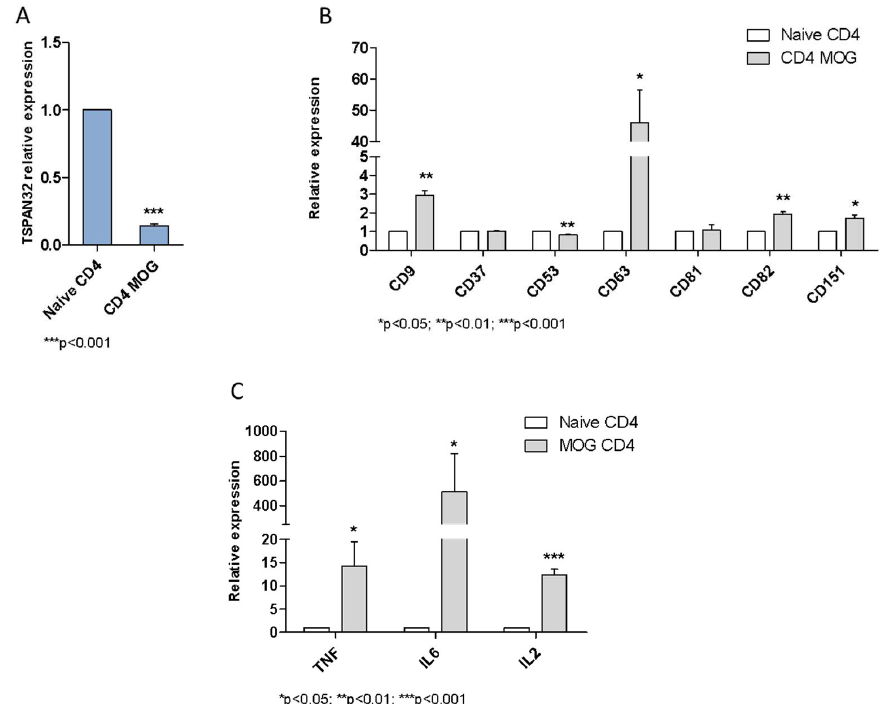
Figure 5. Modulation of TSPAN32 in experimental allergic encephalomyelitis (EAE). ( A ) Expression of TSPAN32 was evaluated using real-time PCR in CD4 + T cells isolated from the brains and spinal cords of mice with EAE. Control cells are represented by CD4 + T cells isolated from the spleens of sham mice ( n = 3 replicates, each of 3 pooled animals). ( B ) Expression of CD9, CD37, CD53, CD63, CD81, CD82 and CD151 was evaluated using real-time PCR in CD4 + T cells isolated from the brains and spinal cords of mice with EAE. Control cells are represented by CD4 + T cells isolated from the spleens of sham mice ( n = 3 replicates, each of 3 pooled animals). ( C ) Expression of TNF-alpha, IL-6 and IL-2 was evaluated by real-time PCR in CD4 + T cells isolated from the brains and spinal cords of mice with EAE. Control cells are represented by CD4 + T cells isolated from the spleens of sham mice ( n = 3 replicates, each of 3 pooled animals). Data are shown as normalized mean ± SD and statistical analysis performed using one-way ANOVA followed by Bonferroni multiple test